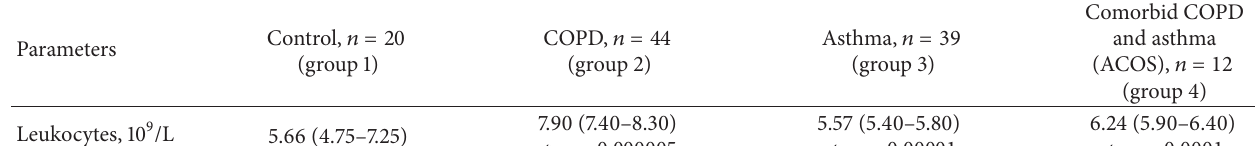
Table 2: Parameters of immune status in patients with COPD, asthma, and